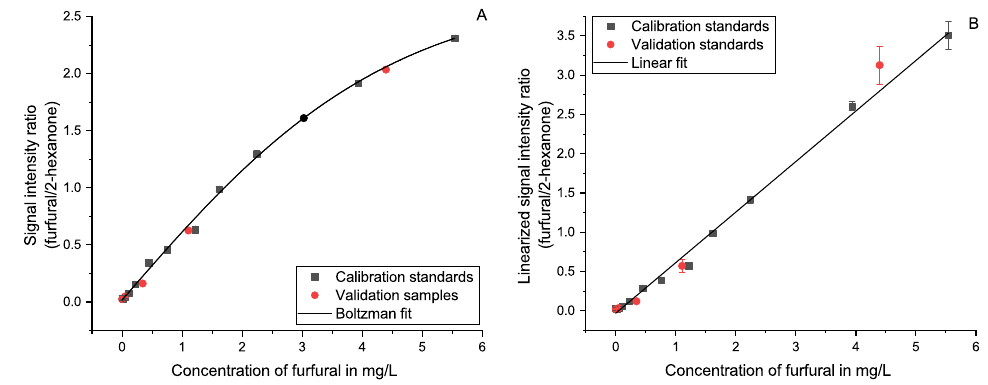
Figure 5. Calibration regression for furfural using 0.1 mg/L 2-butanone as an internal standard in matrix; based on a Boltzmann function ( A ) and a linearly converted function ( B